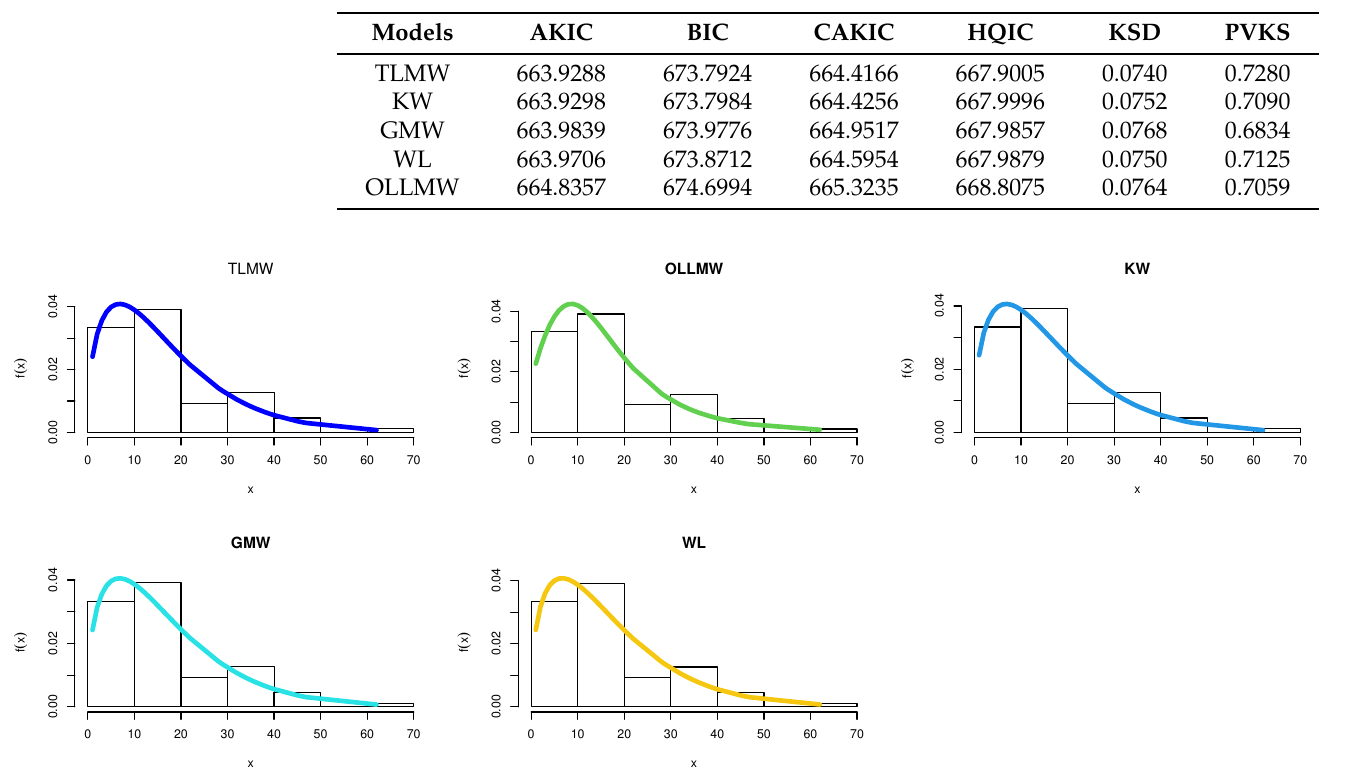
Table 8. Discrimination criteria and KS test of the TLMW model parameters for COVID-19 data.